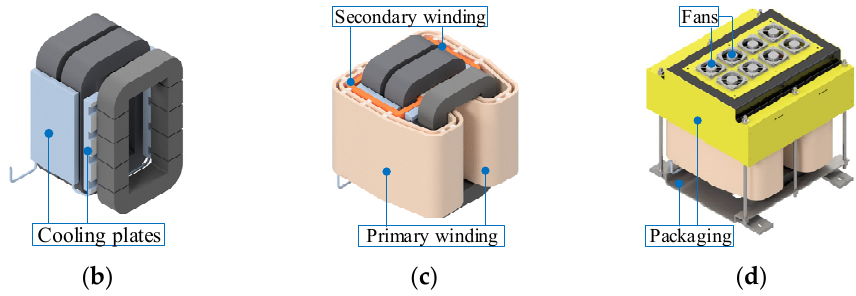
Figure 16. The structure of CW ELII MFT. ( a ) Cores; ( b ) water-cooling system; ( c ) windings; ( d ) packaging and fans.